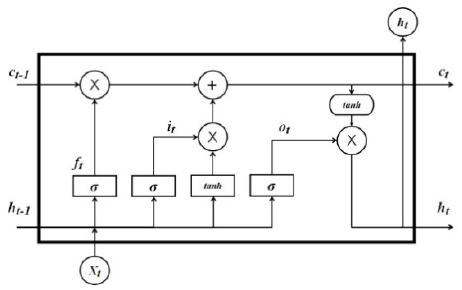
Figure 8. Long Short ‐ Term Memory (LSTM) cell.